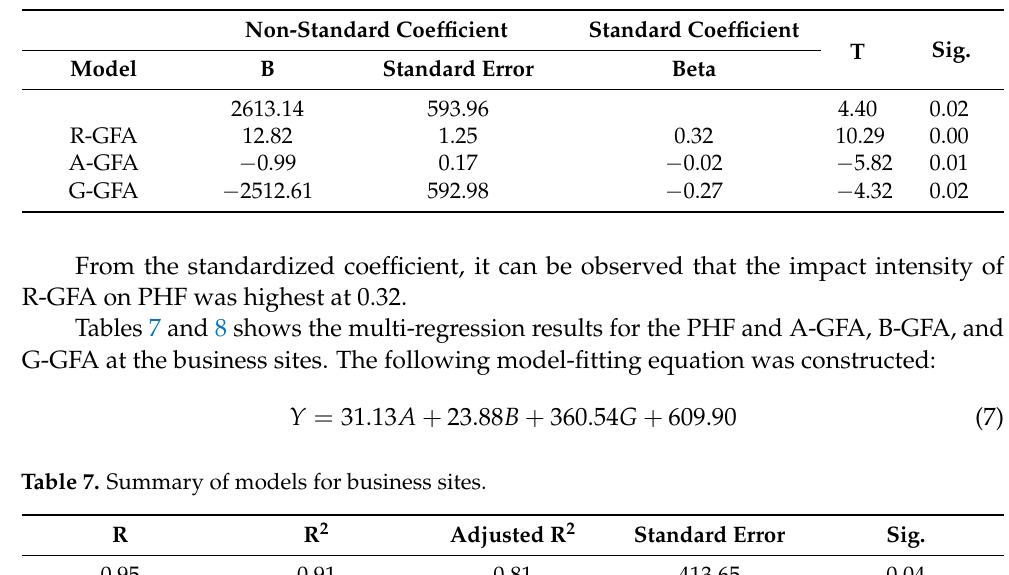
Table 6. Corresponding coefficients.